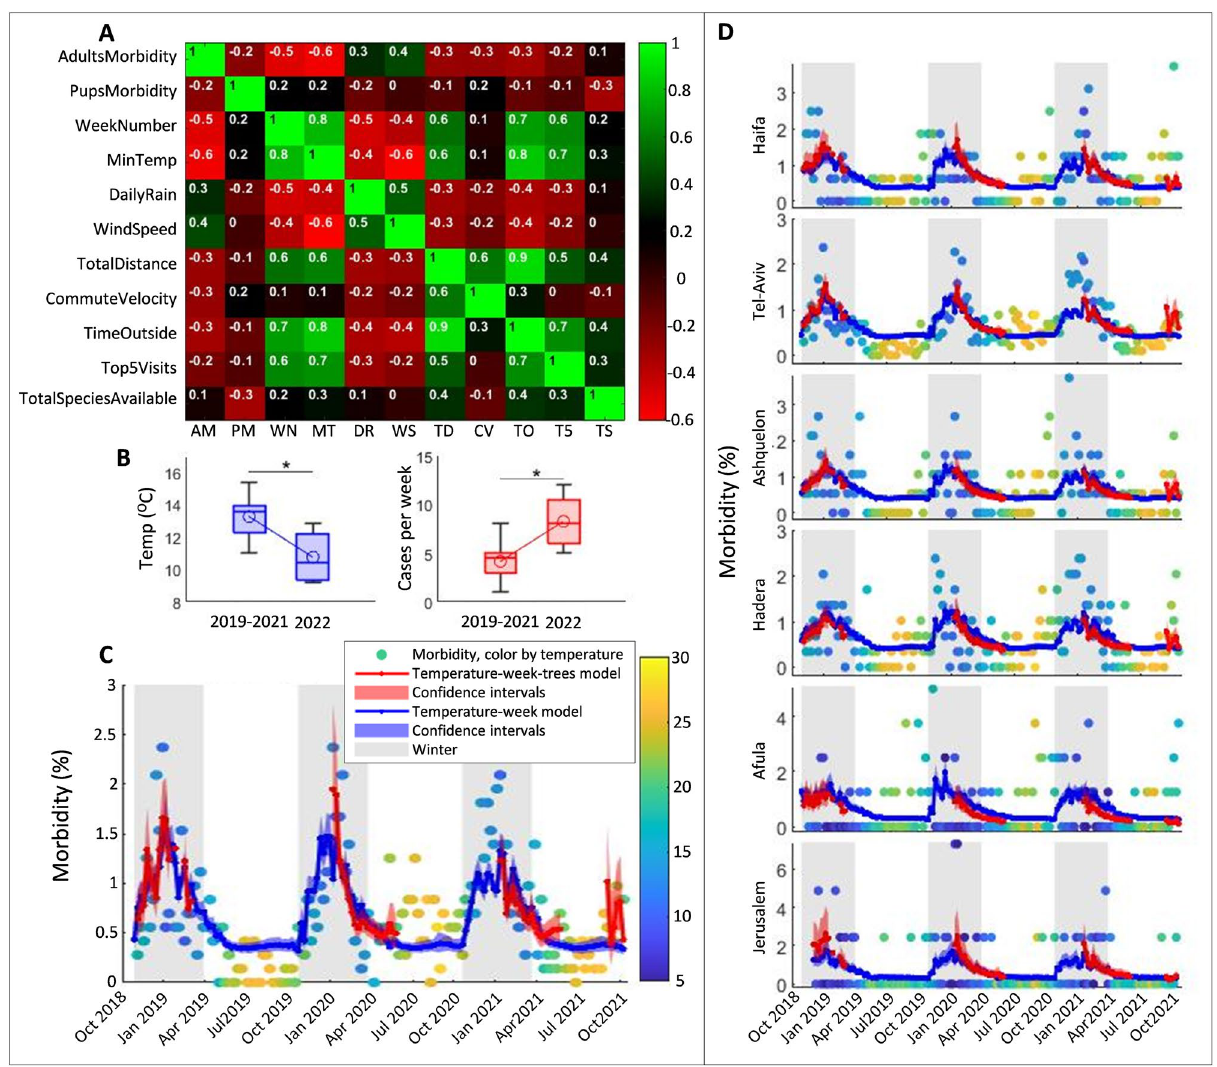
over a week (°C); DailyRain (DR): the average daily precipitation over a week (mm); WindSpeed (WS): the average of the daily maximal wind-speed (m/s); TotalDistance (TD): the total distance the bats flew each day (km); CommuteVelocity (CV): the average flight velocity during the commute (m/min); TimeOutside (TO): the average time the bats spent outside their colony (hours); Top5Visits (T5): the average number of visits by each bat to one the five preferred tree species; TotalSpeciesAvailable (TS): the average total number of different tree species the bats visited each week). ( B ) Adult Morbidity in March: an extremely cold period in March 2022 (left panel) was correlated with a significant increase in morbidity (right panel) relative to the equivalent period in the previous three years. Asterisks indicate a significant difference, see "Results" section. ( C ) Adult morbidity along the central coastline over time. ( D ) Adults morbidity in six different regions in Israel. In panels ( A , D ): The average minimum daily temperature is depicted by a color code ranging from blue (~ 5 °C) to yellow (~ 27 °C). Blue lines and shaded areas indicate the prediction and the 95% confidence intervals of the temperature- winter model for the entire period. Red lines and shaded areas indicate the prediction of the best-fitted model, including the monitored visits to the favorite fruit trees (see